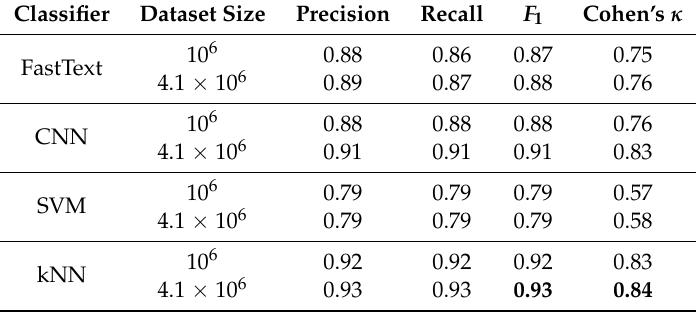
Table 3. Overall results on the validation set for all the classifiers using a dataset of 10 6 samples and the full dataset (4.1 × 10 6 ) samples. Both experiments were performed using 20% of the prototypes for validation and 80% for training. The best results are marked in